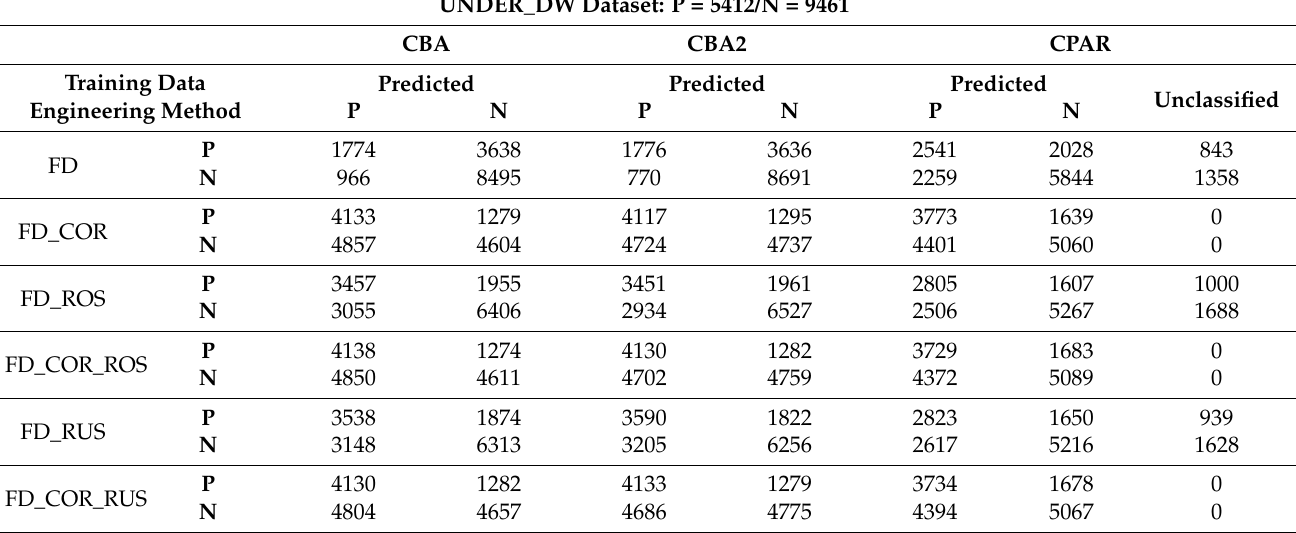
Table 7. UNDER_DW classification results (confusion matrixes) per algorithm and training data engineering method.